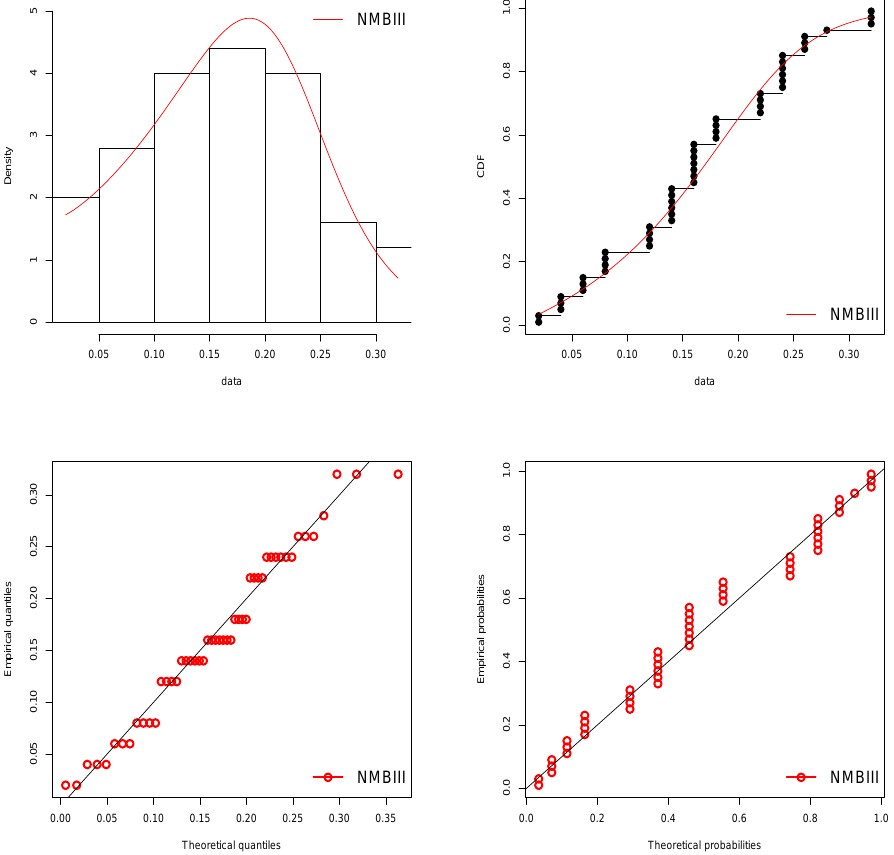
Figure 4. Estimated density ( top left ), cdf ( top right ), QQ-plot ( bottom left ) and PP-plot ( bottom right ) for data set